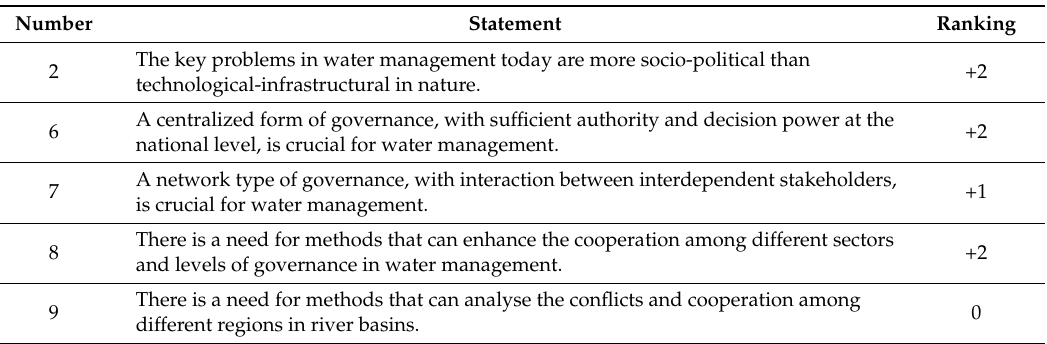
Table 11. Distinguished statements about IWRM in frame